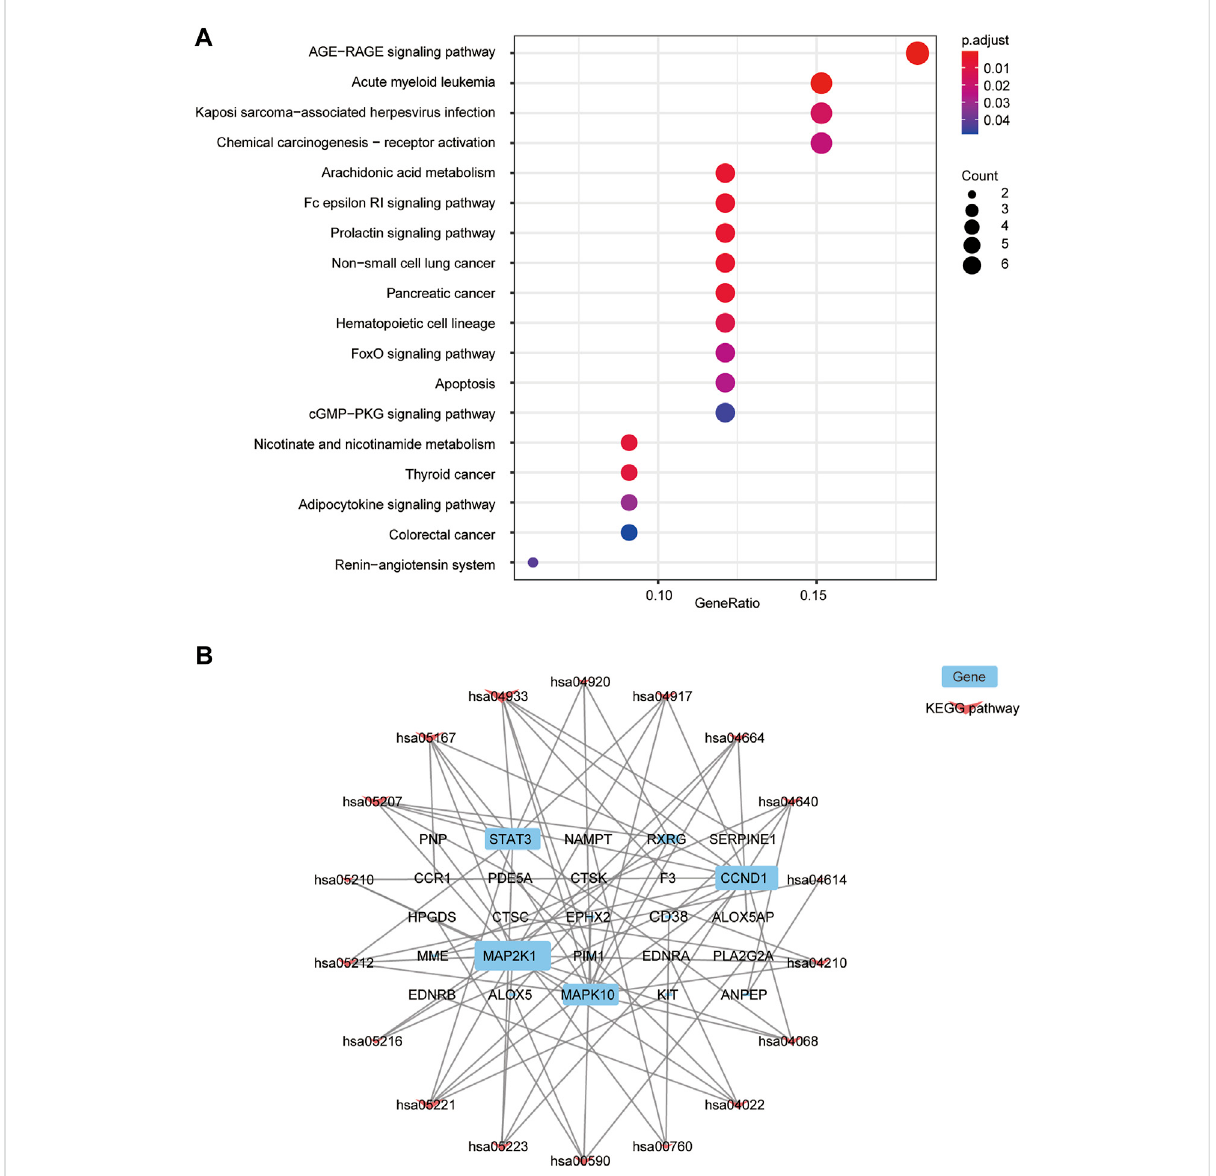
FIGURE 4 KEGG functional analysis. (A) KEGG bubble diagram. (B) Interaction network of 25 targets (blue) and 18 pathways (pink) to indicate pathways- targets